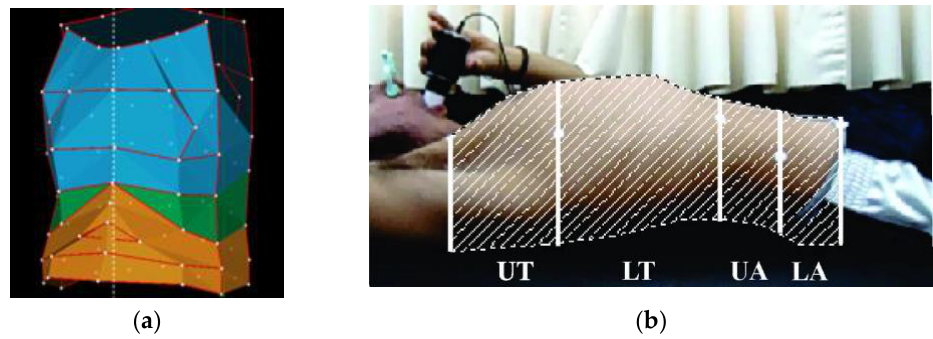
Figure 4. Selection of a region of interest for depth-based plethysmography: ( a ) Subdivision into three subregions: pulmonary rib cage (blue), abdominal rib cage (green), and the abdomen (orange). White dots represent attached markers. Image taken from [56], licensed via Creative Commons License and cropped for this work.; ( b ) Subregions in lateral view: upper thorax (UT), lower thorax (LW), upper abdomen (UA), lower abdomen (LA). Image taken from [21], licensed via Creative Commons Attribution License and cropped for this work.